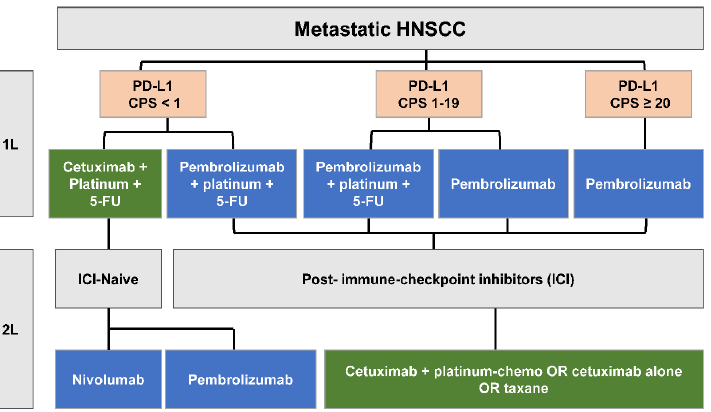
Figure 1. Standard-of-care treatment algorithm for metastatic HNSCC. 1L = first line, 2L = second line, CPS = combined positive score, 5-FU = 5-fluorouracil, ICI = immune-checkpoint inhibitor.